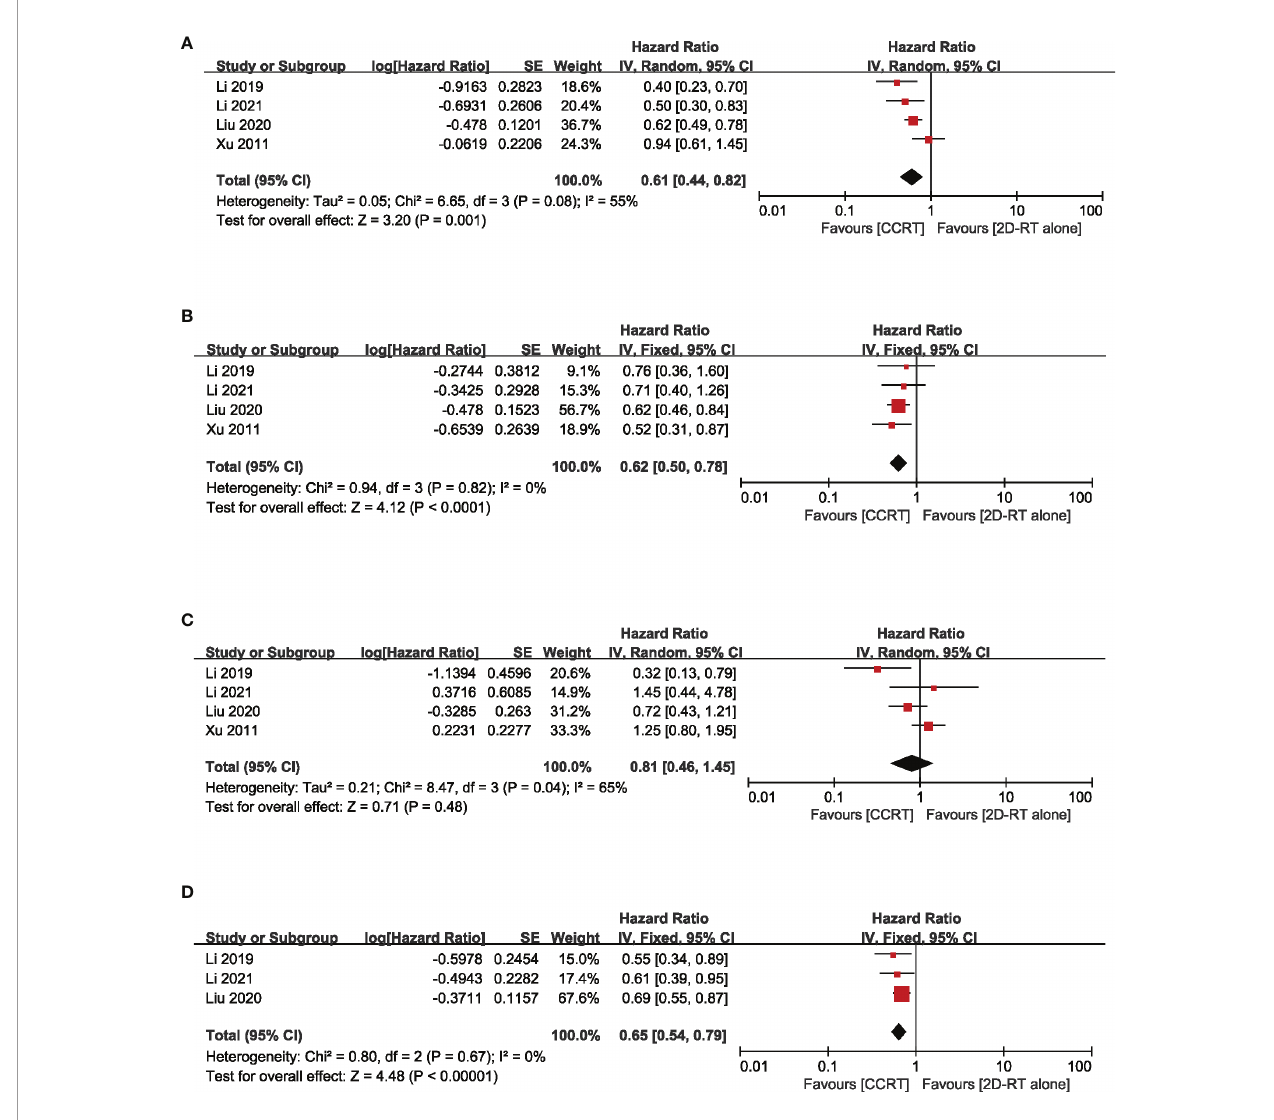
FIGURE 3 | Forest plot of the meta-analysis regarding OS (A) , LRFS (B) , DMFS (C) , and PFS (D) with CCRT vs. 2DRT alone. OS, overall survival; LRFS, locoregional recurrence-free survival; DMFS, distant metastasis-free survival; PFS, progression-free survival; CCRT, concurrent chemoradiation; 2D-RT, two- dimensional